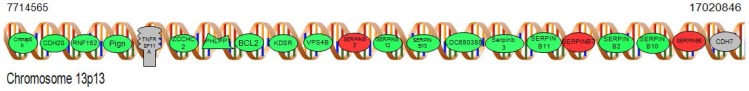
Rat chromosome 13p13 is a significantly enriched chromosomal position.The region has an overall decrease of −1.39-fold. Genes are shown in their position relative to the other genes from position 7,714,565 to 17,020,846. Red indicates the gene in increased in mRNA abundance in the hair follicle while green indicates that the gene is decreased in mRNA abundance.